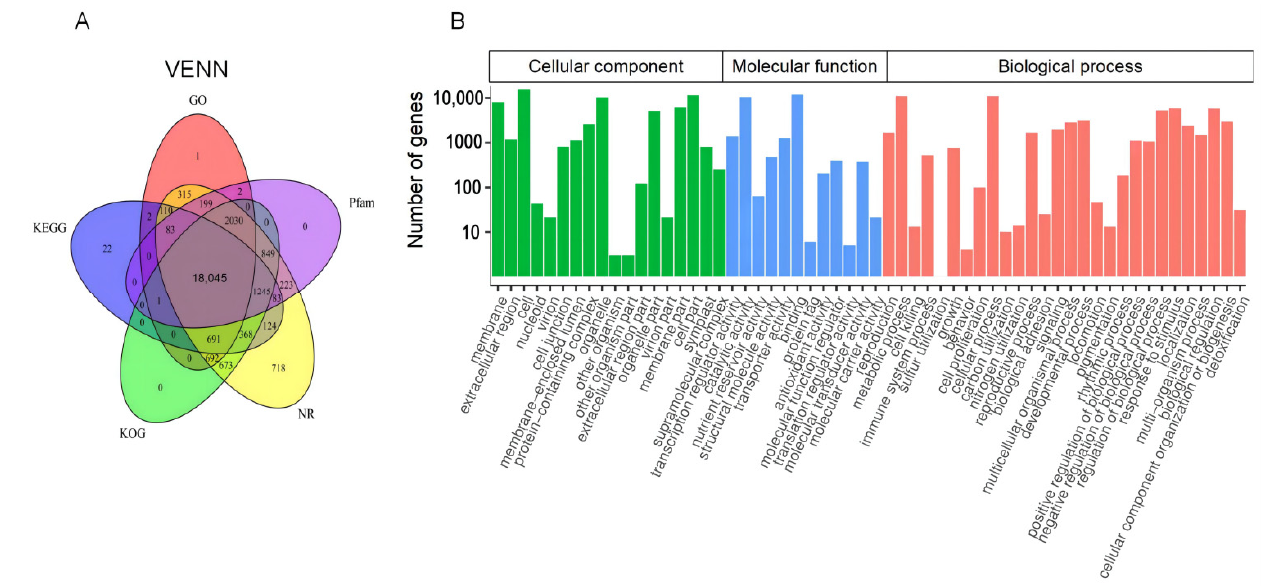
Figure 2. Annotation information of assembled unigenes in sacred lotus. ( A ) Venn diagram of the distribution of annotation information from different public databases. ( B ) GO classification of unigenes. The abscissa represents the secondary GO entry and the ordinate represents the number of genes in the GO entry. The secondary GO entry includes three parts: molecular function, biological process, and cell